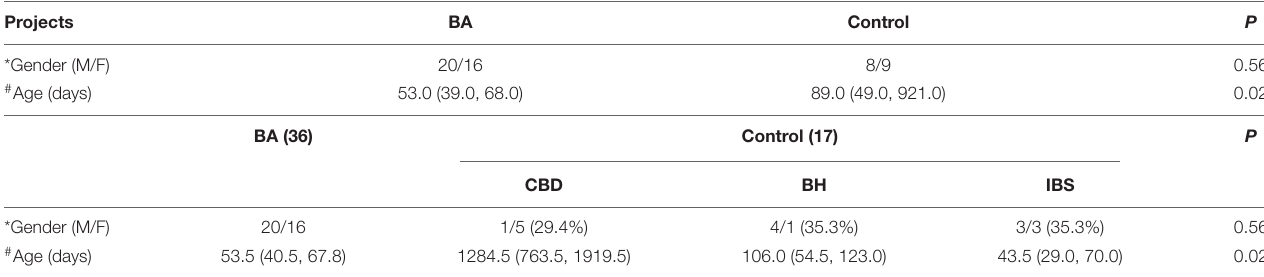
TABLE 2 | Demographic characteristics of study subjects. Projects BA